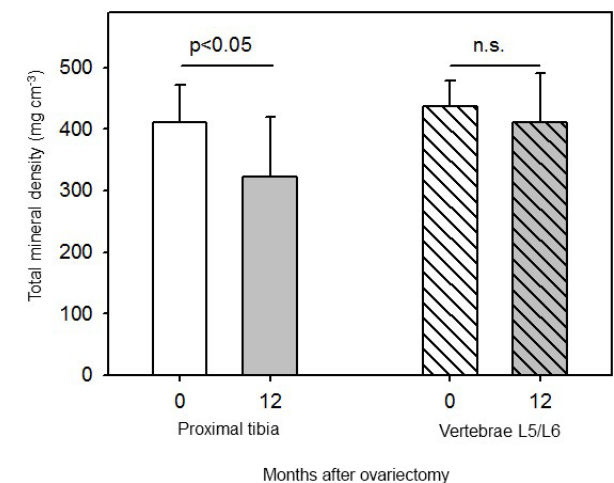
Figure 5. Total mineral density in proximal tibia and in the second- last lumbar vertebrae (L5/L6) in six female marmoset monkeys before (0 months) and 12 months after ovariectomy (mean ± SD, paired t